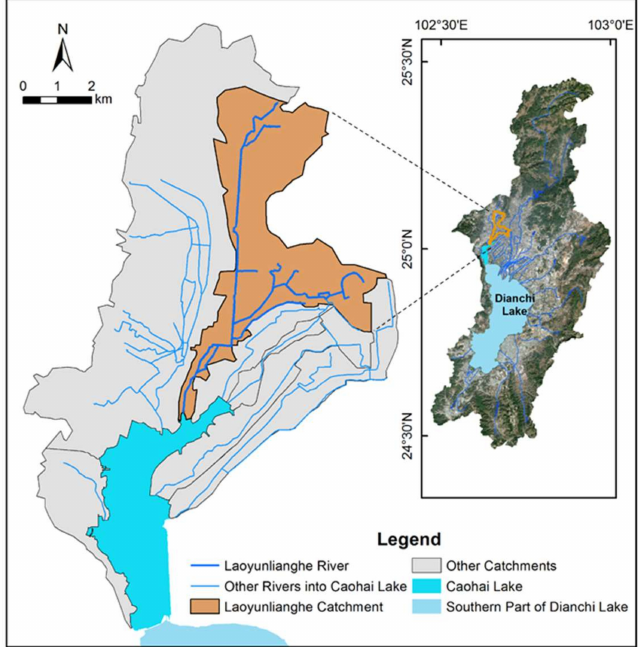
Figure 2. The Laoyunlianghe River catchment situated in the north of Dianchi Lake. The Laoyunlianghe River is one of the seven rivers into Caohai Lake, the northern part of Dianchi